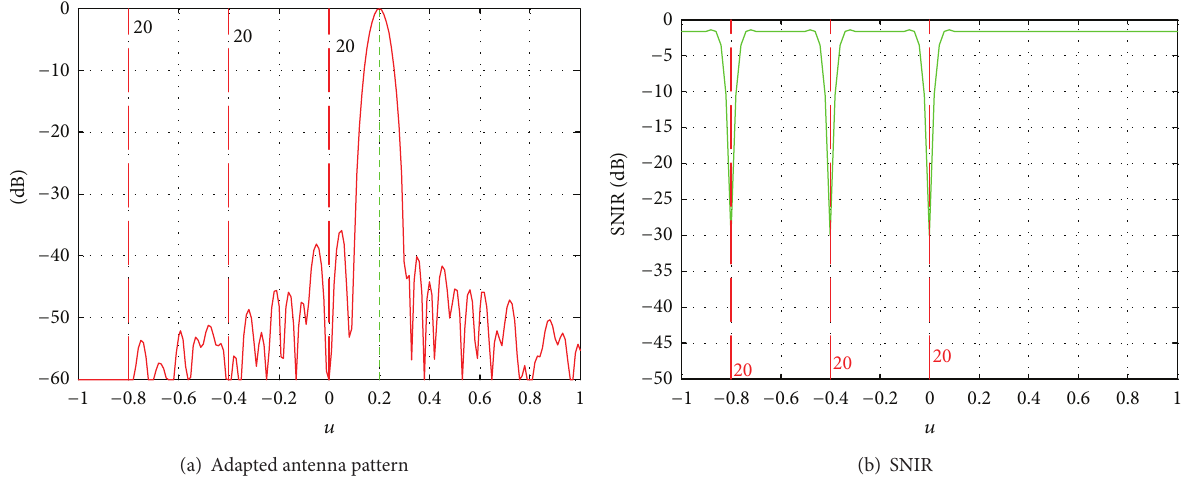
Figure 6: Antenna and normalized SNIR patterns for a three jammer configuration for antenna with low sidelobes ( − 40dB Taylor weighting).